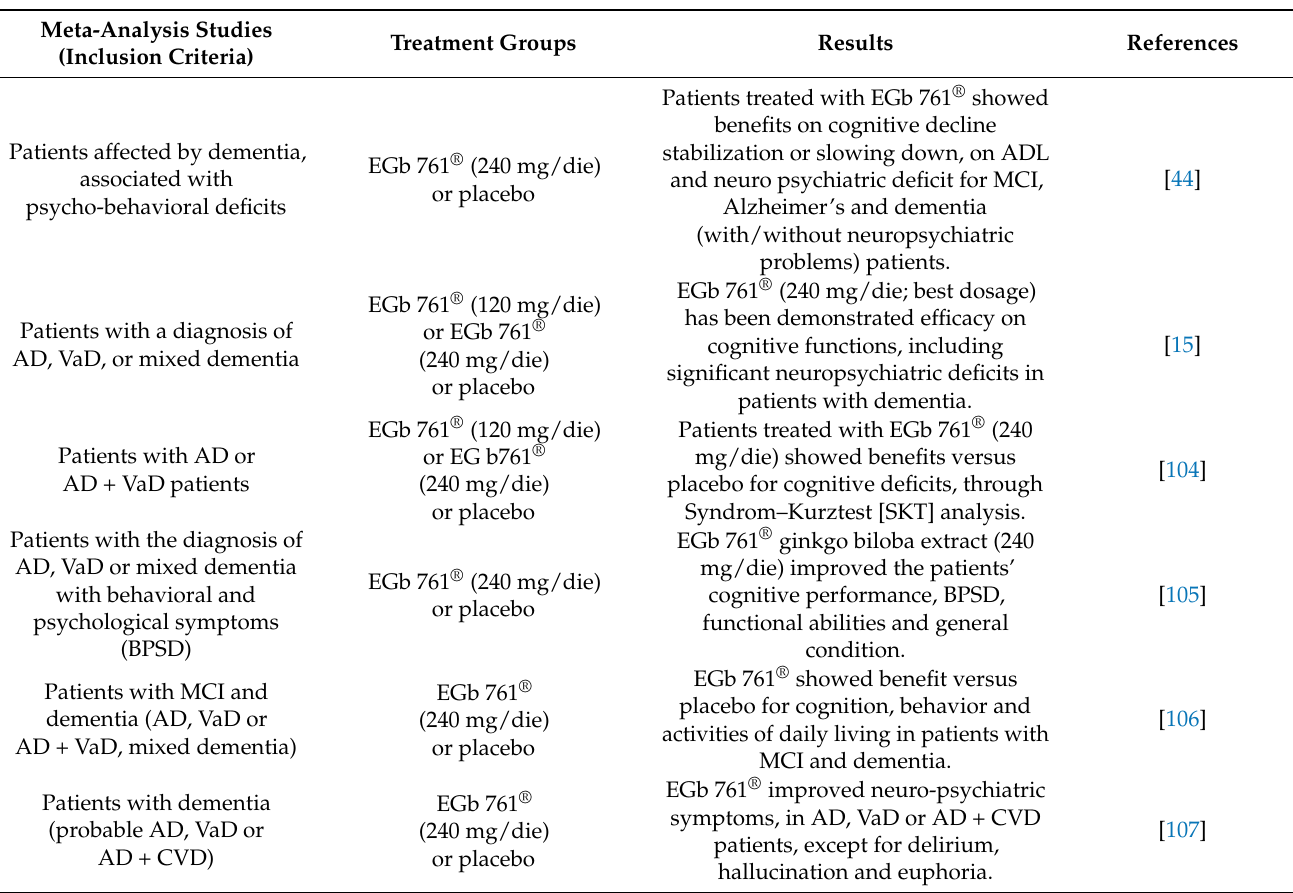
Table 3. Meta-analysis studies on the efficacy of EGb 761 ® in patients with MCI, mild and moderate dementia with or without behavioral